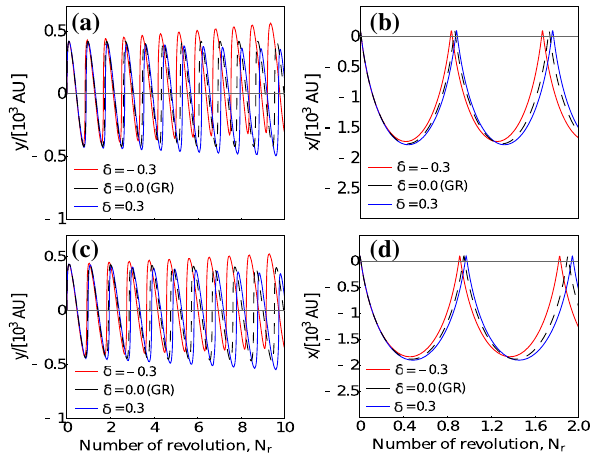
Fig. 2 Equation of motion as function of the number of revolutions. a , b Show the results of the semiclassical approach, while c and d show the numerical integration of the geodesics. The plots are particularized for the case λ = 6000 AU Table 1 Relative variation of the spatial coordinate with respect to the general relativistic value, after one and five revolution. The subscripts δ ± indicates the two values that have been considered ± 0 . 3, while λ is fixed to 6000 AU Semiclassical